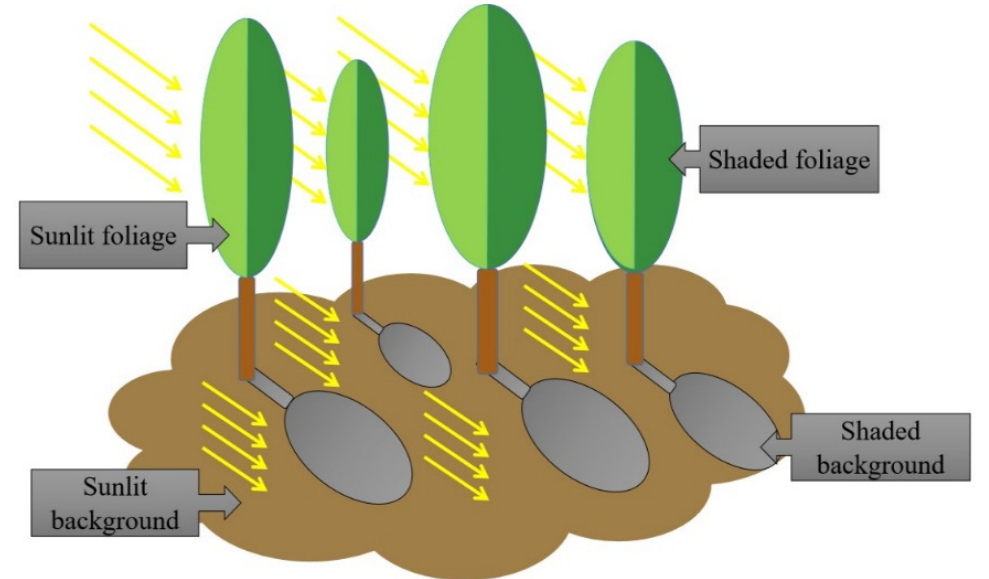
Figure 3. Schematic illustration of sunlit foliage and background and shaded foliage and back- ground.